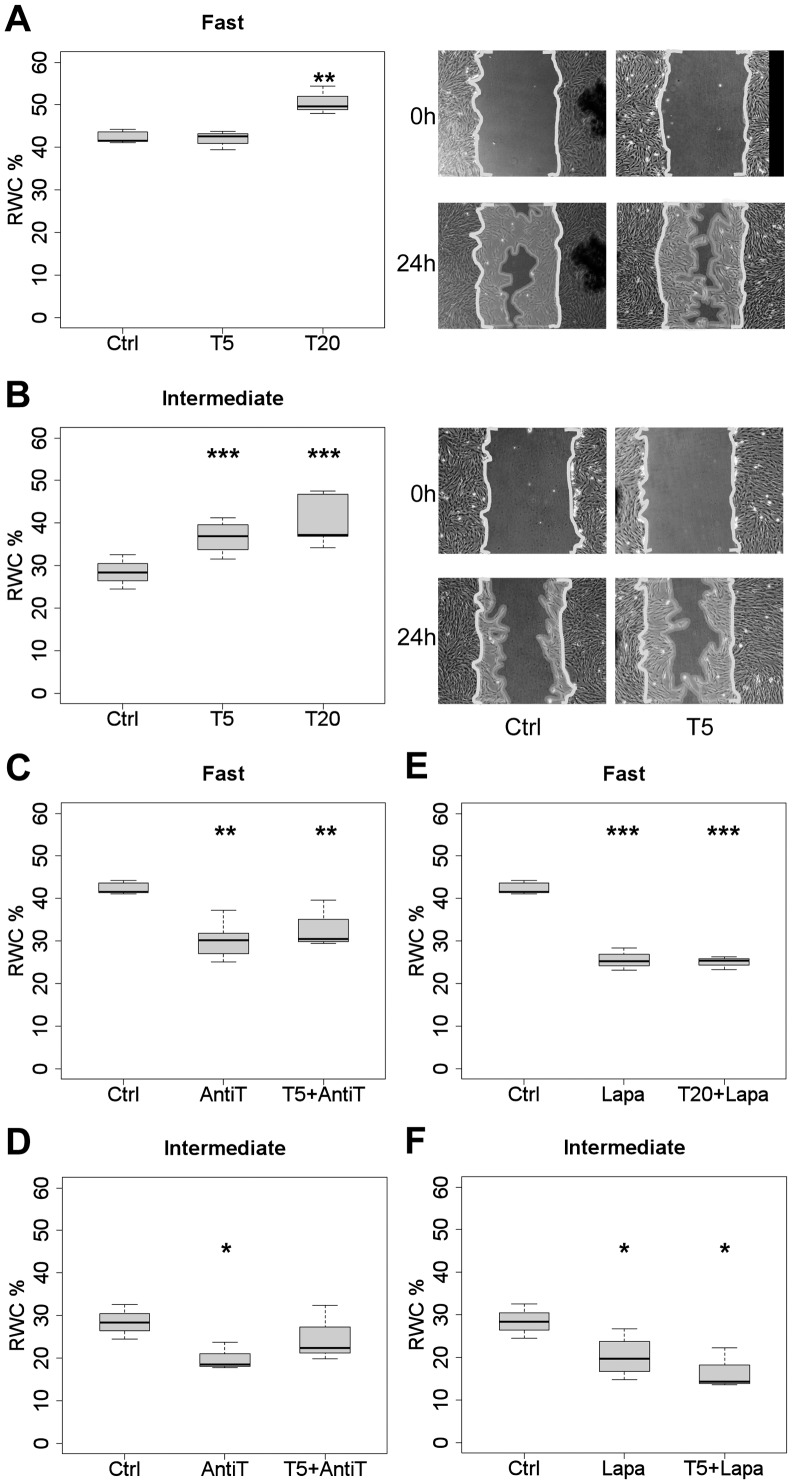
Effect of TGF-α, anti-TGF-α, and EGFR/ERBB2-inhibitor on wound closure by “fast” versus “intermediate” CLP strains.Boxplots depict the RWC in scratch wound assays at 24 h of “fast” (A, C, E) and “intermediate” (B, D, F) CLP strains, in either the absence (control; Ctrl) or the presence of the following agents diluted in 10% FCS/D-MEM: TGF-α at 5 ng/ml (T5) or 20 ng/ml (T20); TGF-α neutralizing antibody at 0.5 µg/ml (AntiT); Lapatinib at 5 µM (Lapa); TGF-α plus anti-TGF-α (T5+AntiT); or TGF-α plus Lapatinib (T5+Lapa; T20+Lapa) (*p<0.05, **p<0.01, ***p<0.001). The micrographs show representative examples of scratch wound assays at 0 and 24 h in the absence or presence of the drugs indicated at the bottom. Area of scale bar corresponds to 10% RWC or 0.32
mm2.